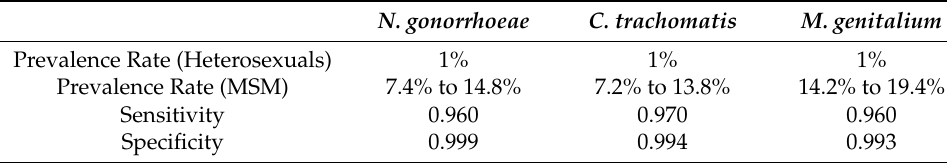
Table 1. Assumptions regarding STI prevalence and test